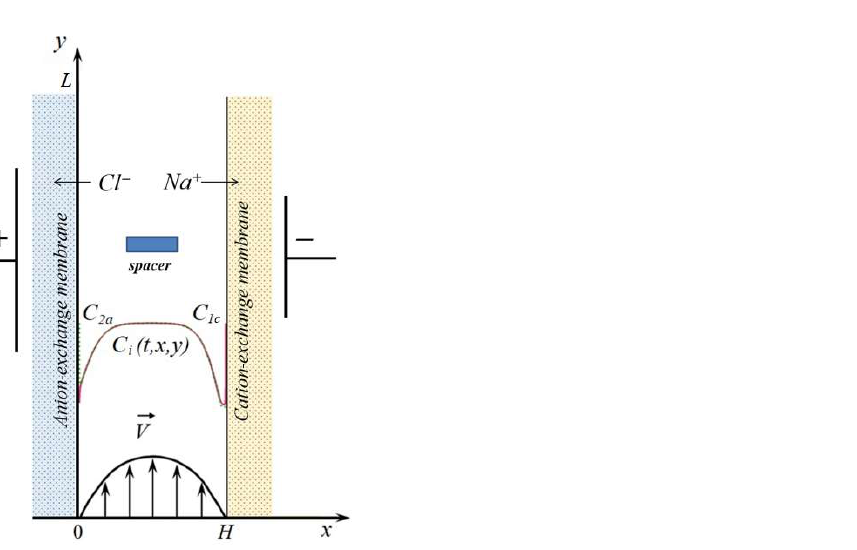
Figure 1. Scheme of a desalination channel formed between the anion- and cation-exchange mem- branes with a rectangular spacer. H and L are the width and length of the channel section. Schemat- ically shown are the concentration profiles of cations ( C 1 , solid line) and anions ( C 2 , dotted line) in the desalination channel, the velocity of forced electrolyte flow at the inlet to the channel V is the anion concentration at the solution/anion-exchange membrane interface; C 1 c is the cation concentration at the solution/cation-exchange membrane interface.